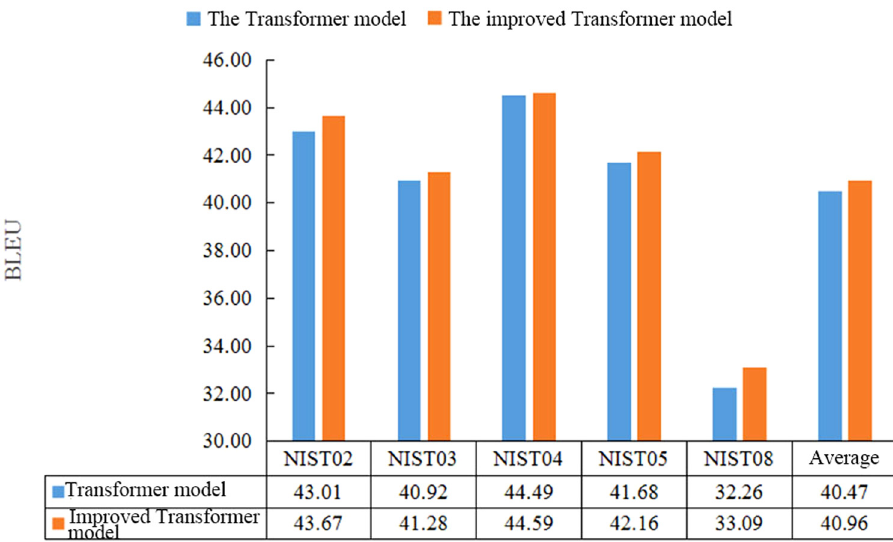
Figure 2: Comparison of BLEU values between di ff erent models.